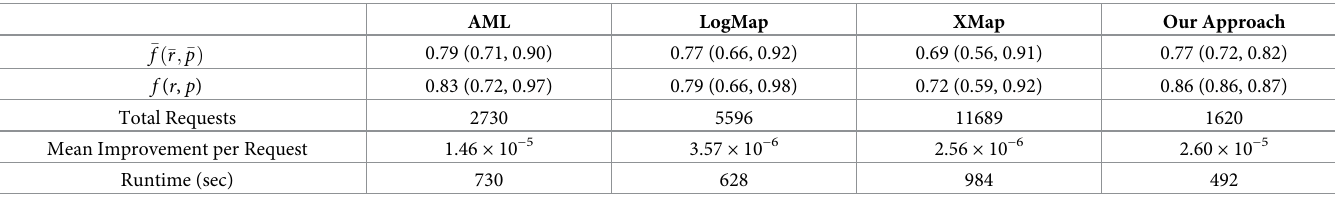
Table 3. Comparison between OAEI 2016’s participants and our approach on the interactive Large Biomedic track: SNOMED-NCI.